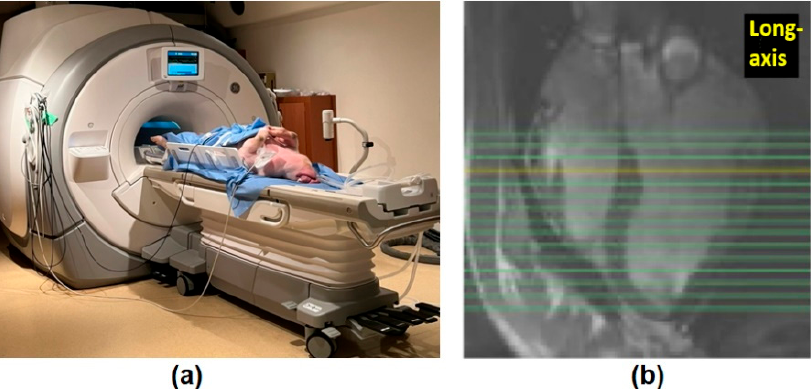
Figure 2. Example of a preclinical MR imaging study: ( a ) experimental set-up with the pig on the table of the 3T MR scanner (prior to placing the animal inside the bore); and ( b ) long-axis image serving for the prescription of the short-axis Cine images.